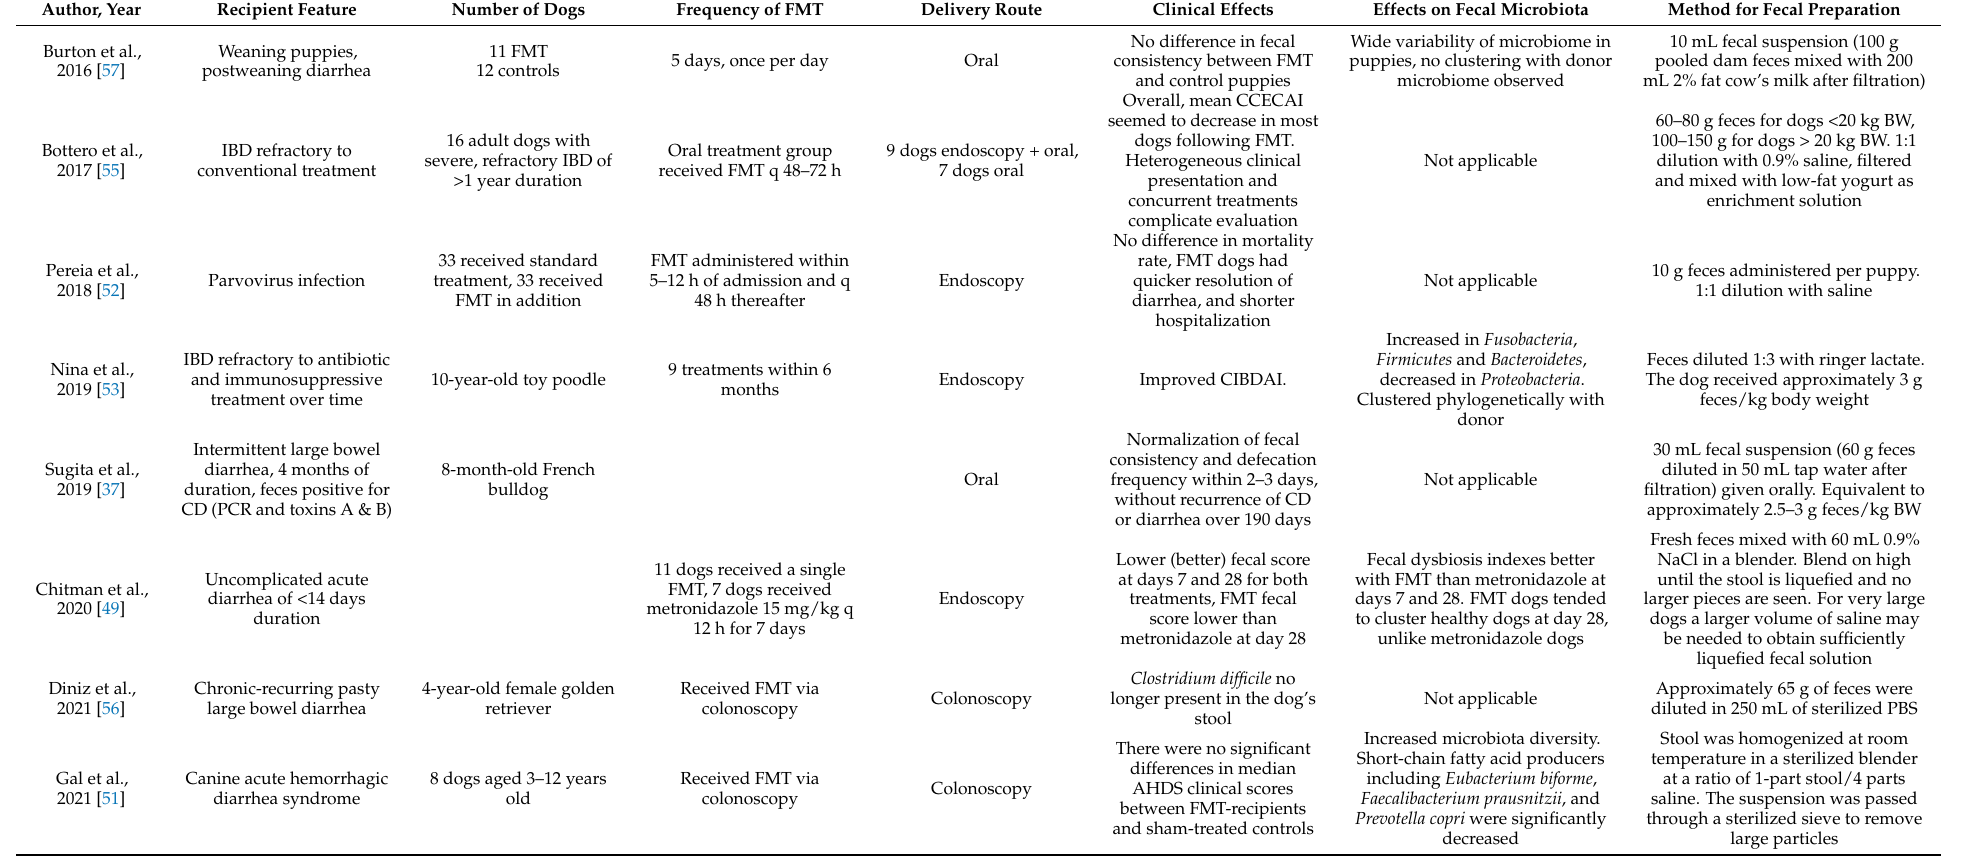
Table 1. Peer-reviewed literature of canine fecal microbiota